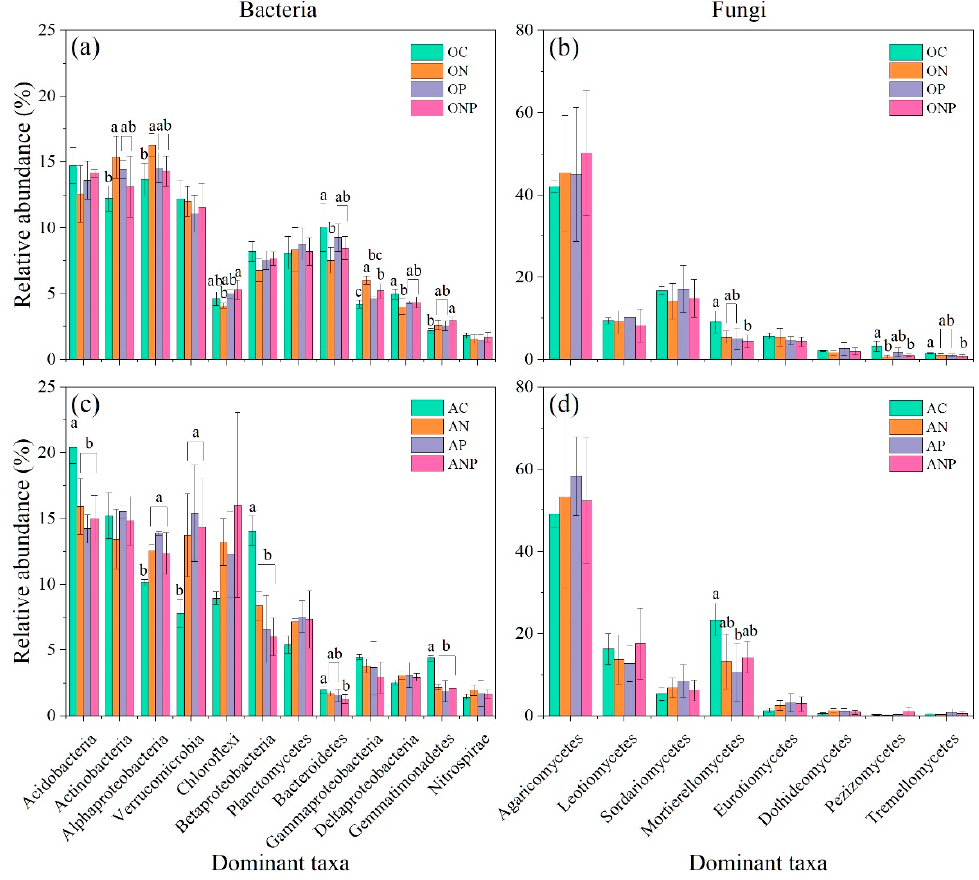
Figure 4. The relative abundance of dominant bacterial ( a , c ) and fungal ( b , d ) groups under N and P additions. Values are mean ± standard deviation ( n = 3). Different letters above the bars indicate significant differences among different fertilization addition treatments (one-way ANOVA, p < 0.05, Duncan’s multiple range test). OC, ON, OP and ONP indicate the O horizon soils (0–5 cm, ( a , b )) under control (C, without N and P addition), N addition, P addition and NP addition, respectively. AC, AN, AP and ANP indicate the A horizon soils (5–15 cm, ( c , d )) under control (C, without N and P addition), N addition, P addition and NP addition, respectively.